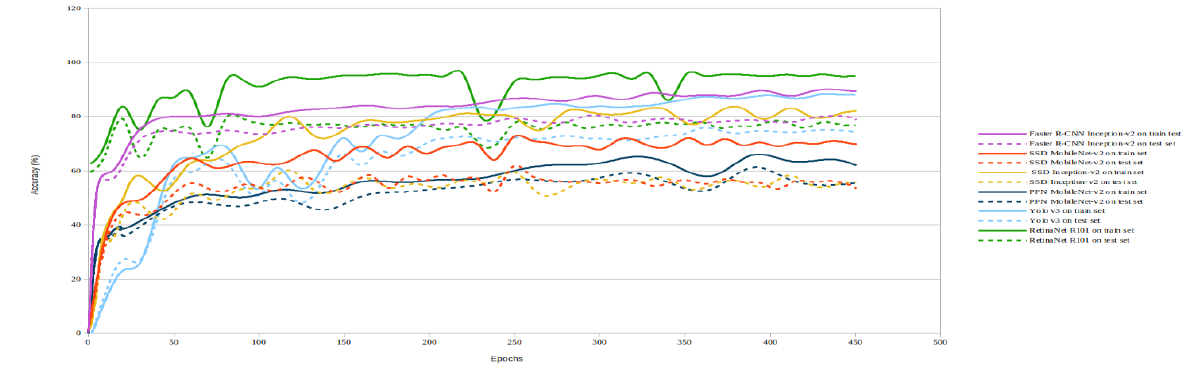
Figure 6. Accuracy vs Epochs diagram for the OD algorithms on train and test